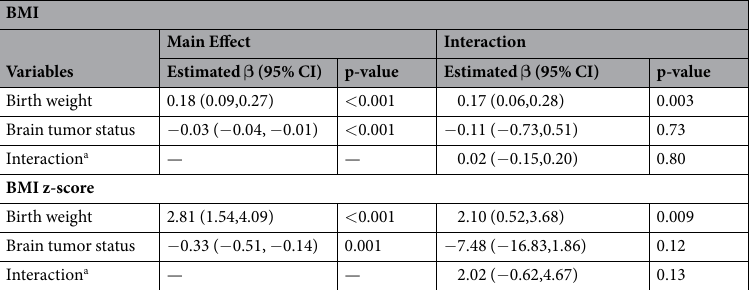
Table 3. Interaction analysis of body mass measures and birth weight in CBT and non-cancer controls. Abbreviations: CBT, Children with Brain Tumors; BMI, Body Mass Index; CI, Confidence Interval. Models were adjusted for age, sex, puberty, fat mass percentage. a The interaction term was birth weight * brain tumors status